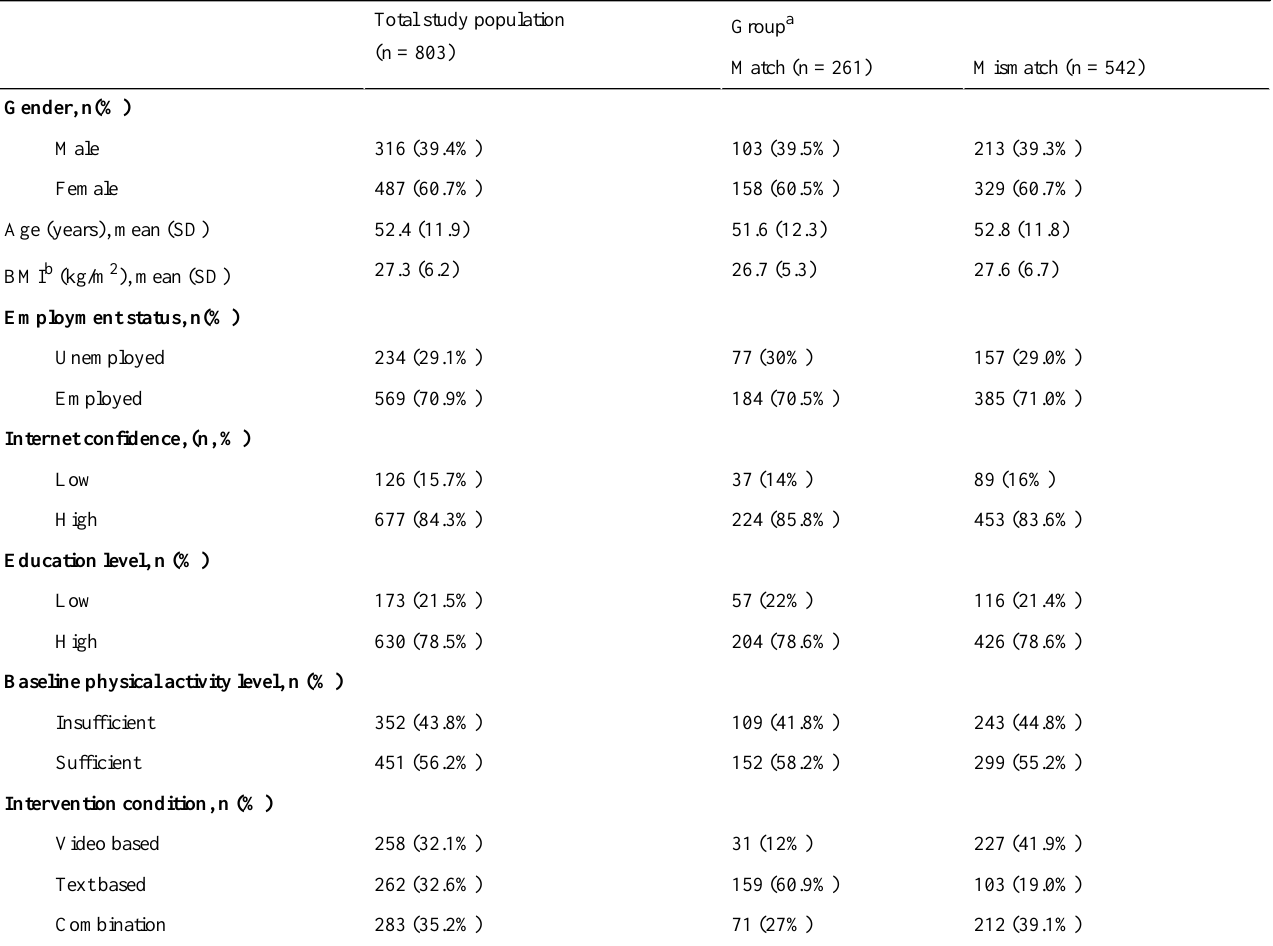
Table 1. Participant characteristics at baseline across matched and mismatched